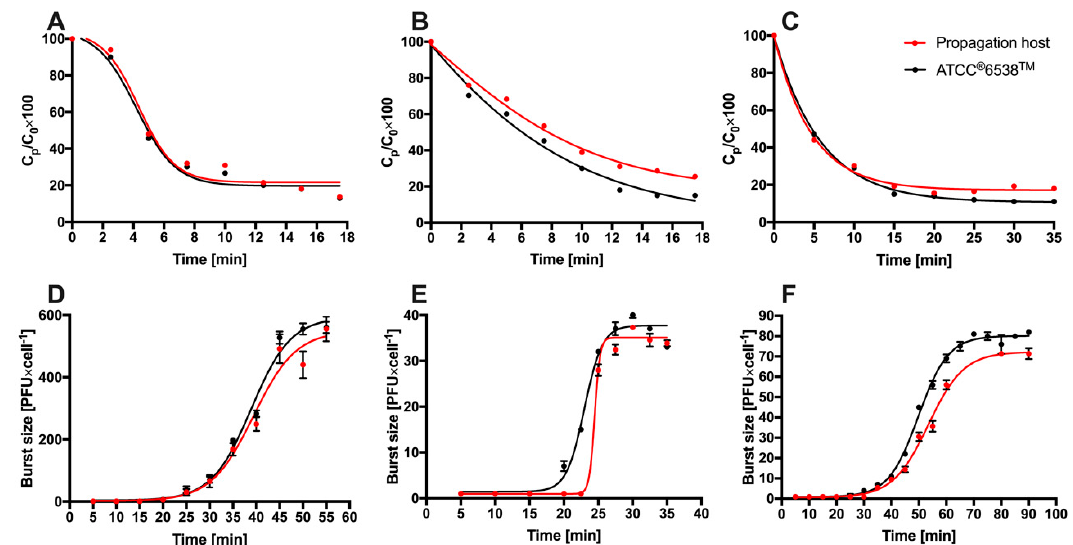
Figure 2. Characterizations of phages vB_SauM-A, vB_SauM-C, vB_SauM-D. Kinetics